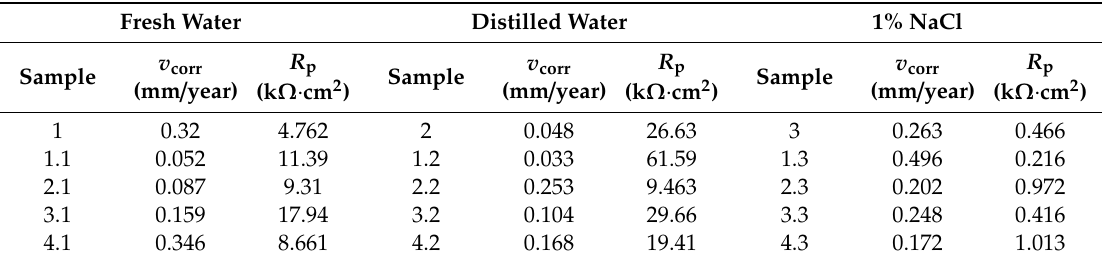
Table 6. Polarization test results of corrosion rate and polarization resistance with and without inhibitor in aqueous solutions.